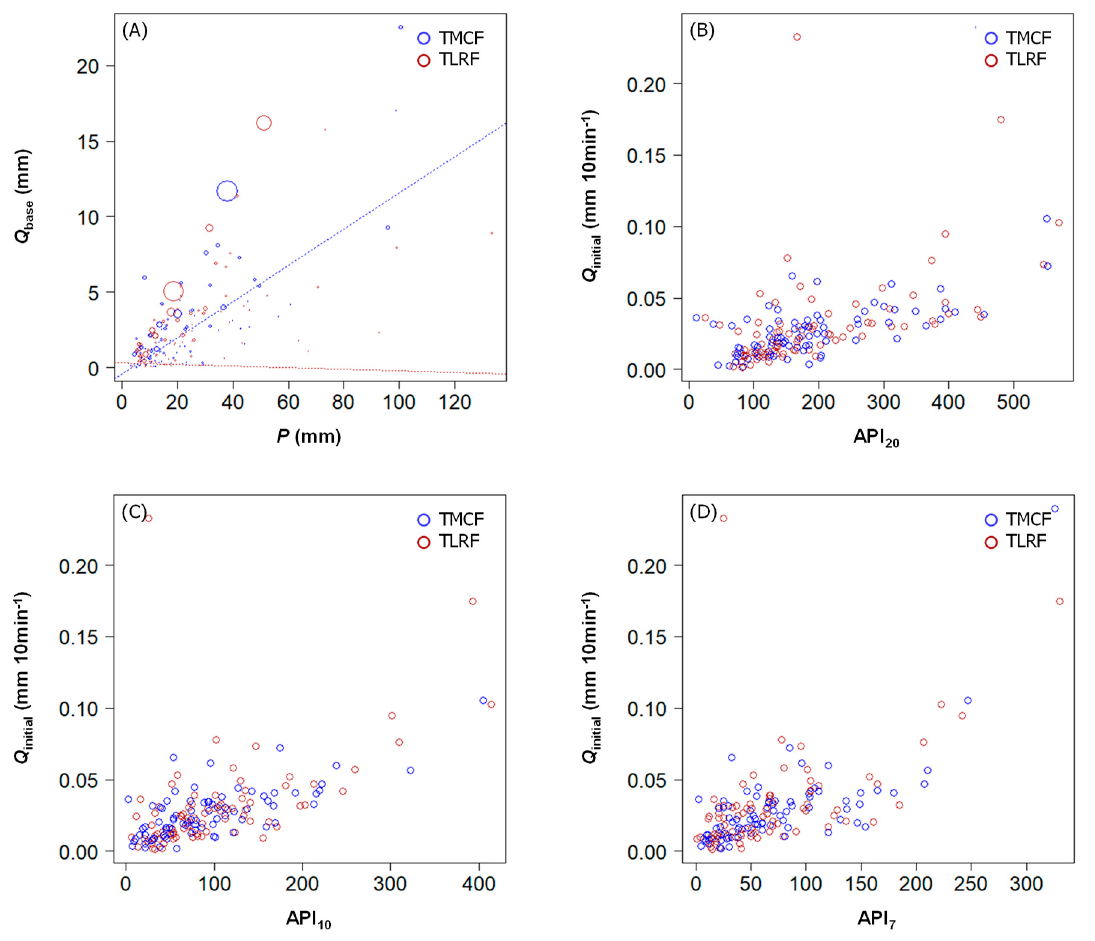
Figure 7. ( A ) Q base versus event rainfall; increasing point size corresponds to increasing Q initial . ( B – D ) Q initial versus API 20 , API 10 , and API 7 , respectively.